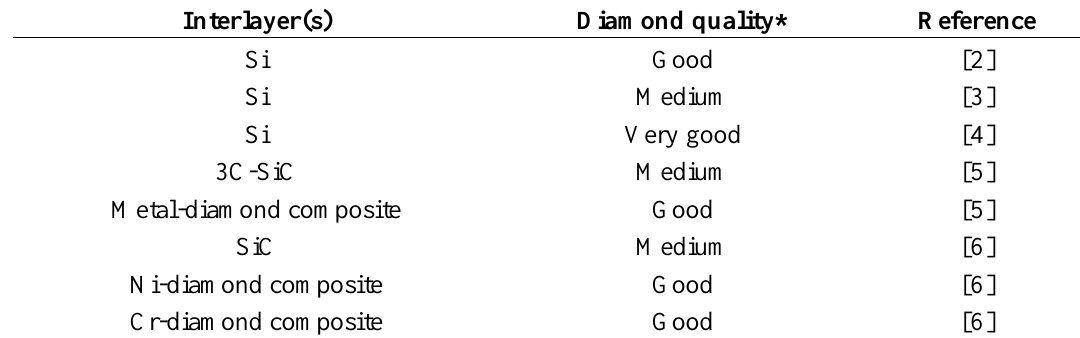
Table 1. Summary of interlayers used for diamond deposition on steels. (*Diamond quality depends on: uniformity, Raman quality, crystallinity, film stress and